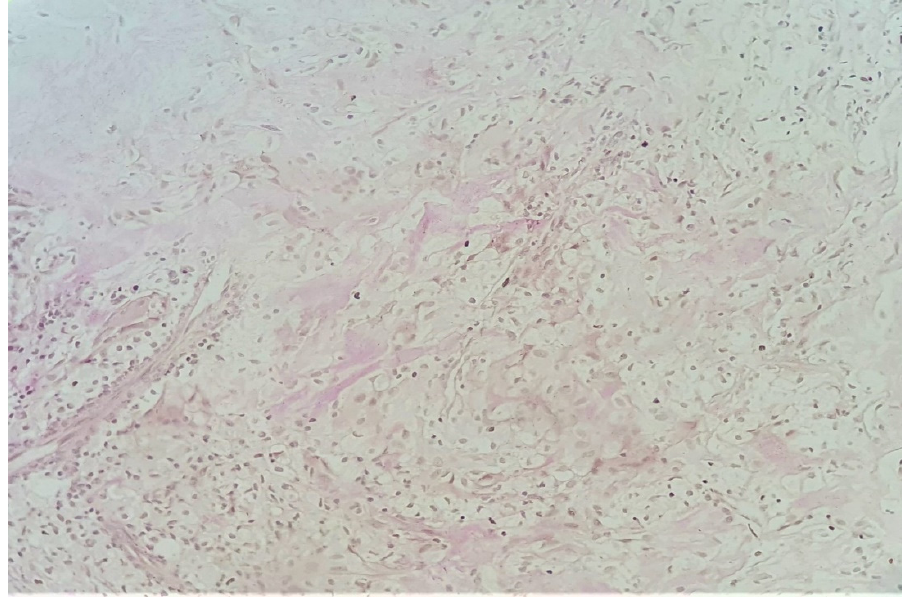
Figure 6. Van Gieson’s stain, 20× lens—close-up of the immature collagen fibers .